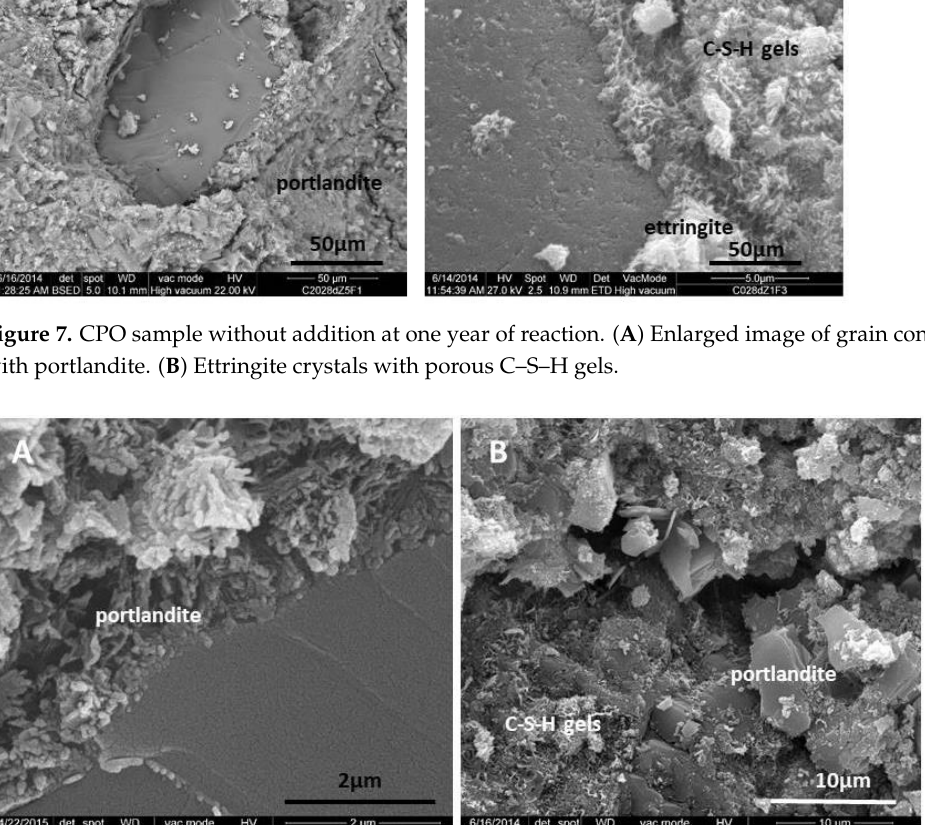
Figure 8. Mortar with 20% substitution at one year of reaction. ( A ) Grain-to-grain contact with oriented portlandite sheets. ( B ) Aggregates have increased in size.